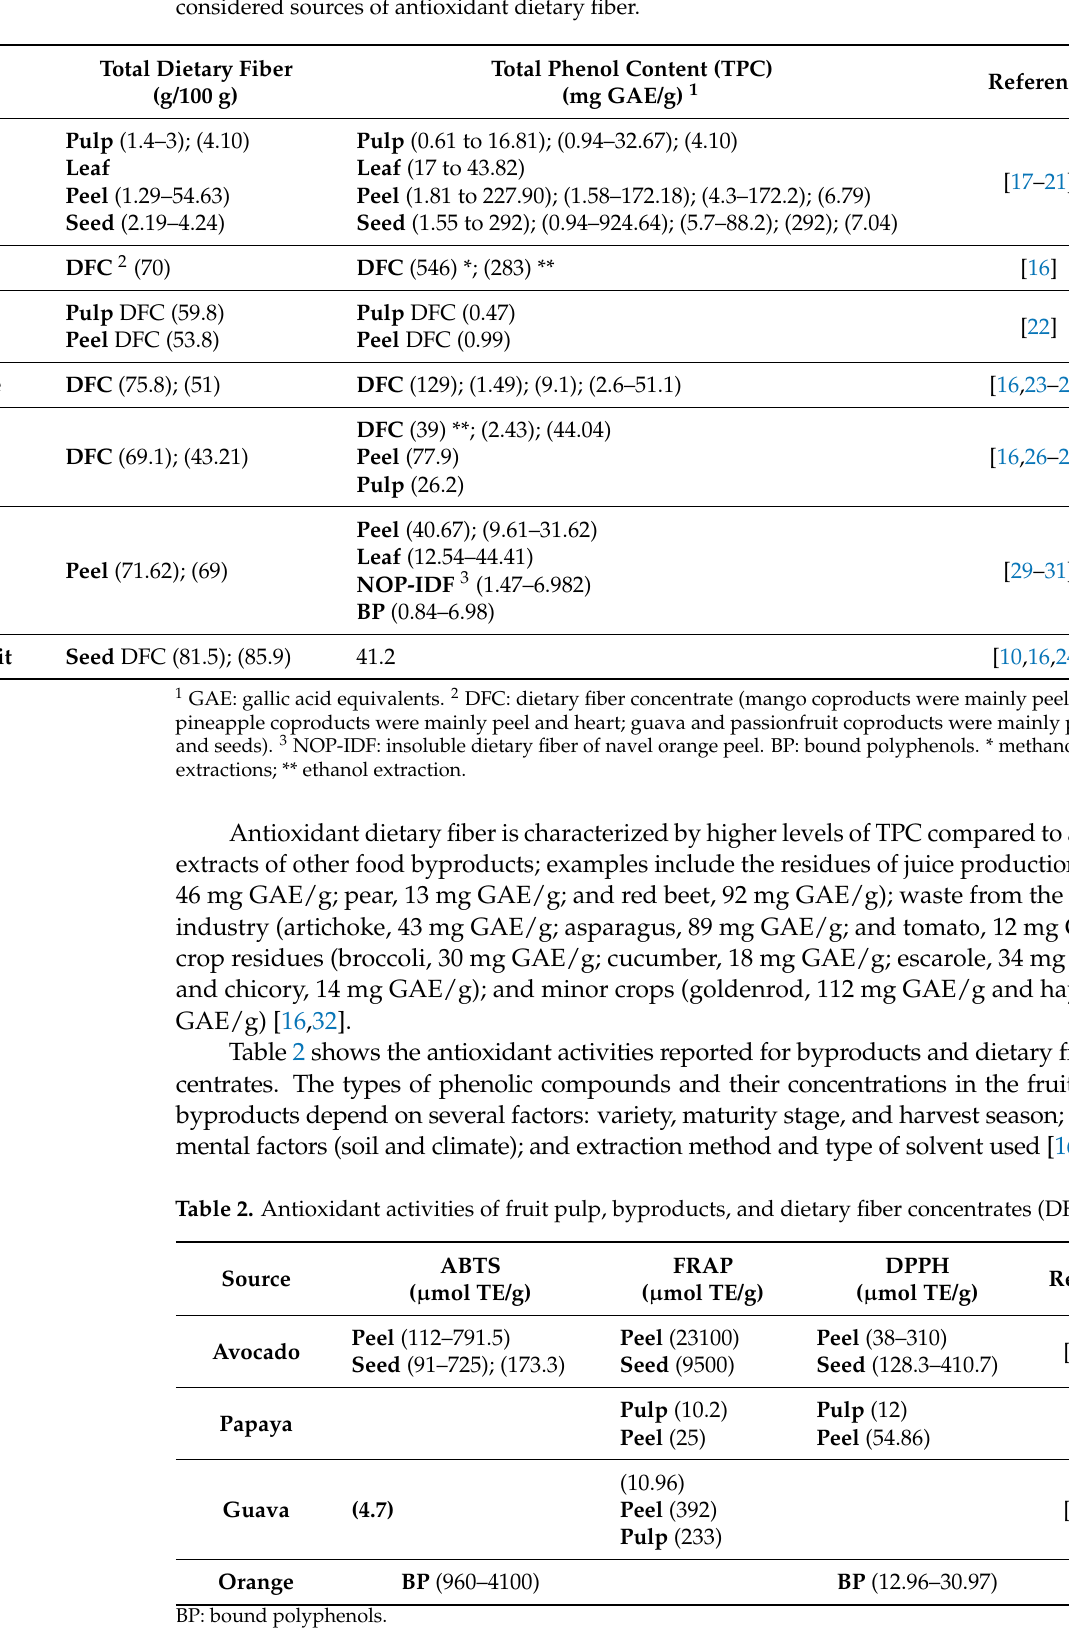
Table 1. Total dietary fiber (TDF) and total phenol content (TPC) of agroindustrial byproducts considered sources of antioxidant dietary fiber.